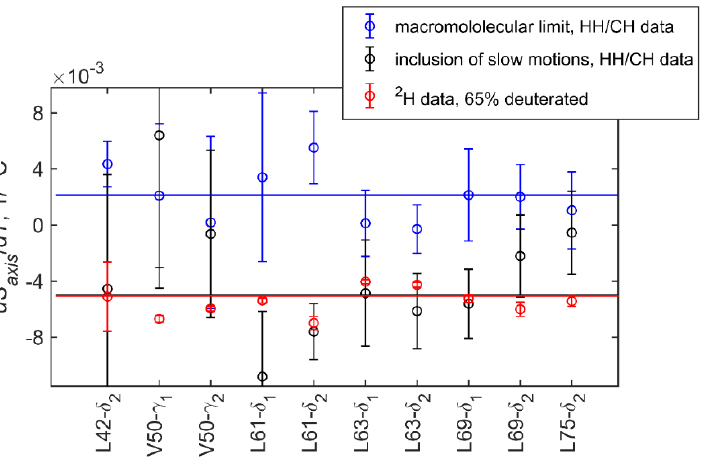
Figure 9. Comparison of methyl axis order parameters 𝑆 𝑎𝑥𝑖𝑠2 in the perdeuterated/LV protonated sample at 32 °C and 22 °C in absence of glycerol-d8 (black circles) and in the presence of 28% w/w glycerol (blue circles) versus site identity. The fits were done according to Equation (4) with 𝜏 𝑓 fixed at 500 ps.